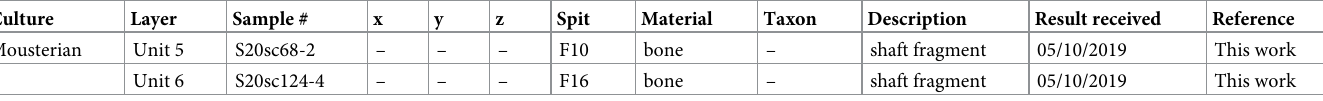
In the interior sequence, such finds occur alongside the remains of hyaena and, like these, are exclusive to the Early Upper and Middle Palaeolithic levels. Table 7. AMS radiocarbon dating in the entrance trench: samples.